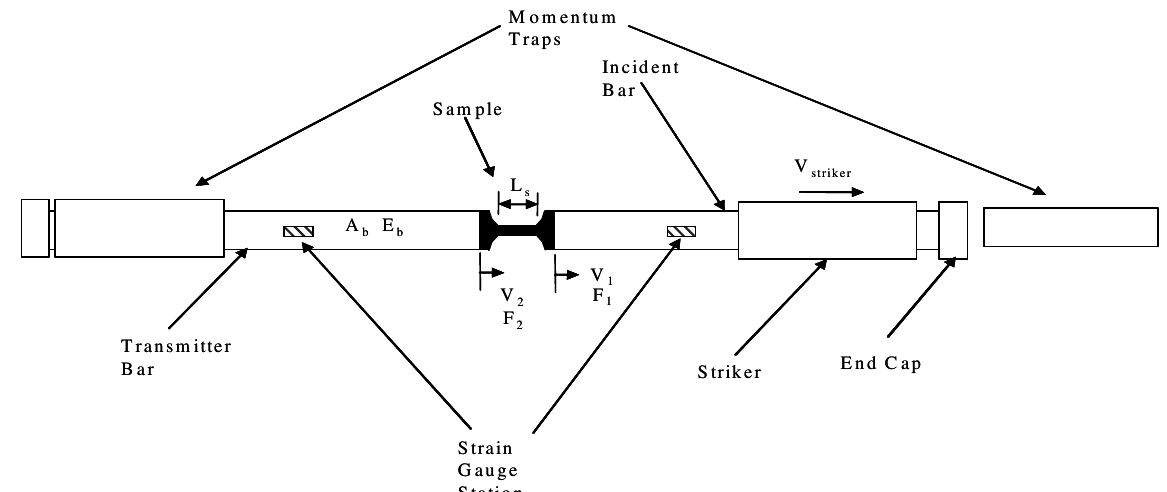
Fig. 4. Schematic diagram of TSHB apparatus at University of Waterloo.